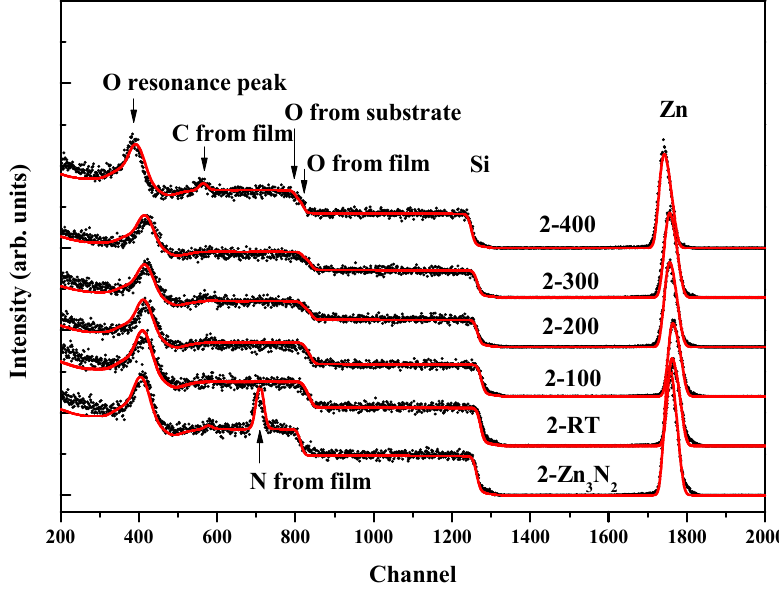
Figure 2. Non-Rutherford backscattering (non-RBS) spectra of as-grown 2-Zn 3 N 2 film and ZnO:N films. The XPS measurement was conducted to investigate the local chemical states of N atoms in the as-grown Zn 3 N 2 film labelled as 2-Zn 3 N 2 and ZnO:N, as shown in Figure 3. Three peaks were found in the as-grown Zn 3 N 2 film at 395.6 eV, 397.8 eV, and 400 eV, which were assigned to Zn-N [21], N-H, and N-N bonds [22], respectively. This agrees with our previous results [18]. After being oxidized in the oxygen plasma, the Zn-N and N-H peaks disappeared, meaning that the film completely transformed into ZnO, and a new peak at 398.6 eV emerged at temperatures ranging from RT to 300 ◦ C. This new peak is suggested to be N O (substitutional nitrogen in oxygen site in the ZnO crystalline) [12,23,24], an acceptor in N-doped ZnO film. Another new peak at 400.8 eV was associated with the characteristic N 1s → π * transition in molecular nitrogen [22]. This indicates that the molecular nitrogen is produced during the oxidizing process. The contents of N and N O of the ZnO:N films are listed in Table 1, which are obtained by simulating XPS data with Gaussian curves. At RT, the film contained 0.4 at % of N elements, among which 0.22 at % of N elements were existing as N O . As the temperature increased—except for the film oxidized at 100 ◦ C—the total N contents in the ZnO:N films changed slightly, while the N O contents reduced and vanished at 400 ◦ C. At 100 ◦ C, the film had 0.23 at % of total N content—the lowest among the ZnO:N films.